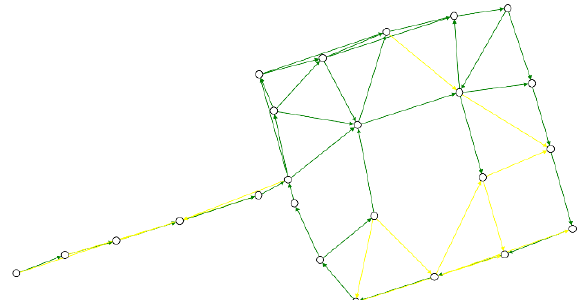
Figure 5. Case Study 1: results of pairwise plane-based registrations.